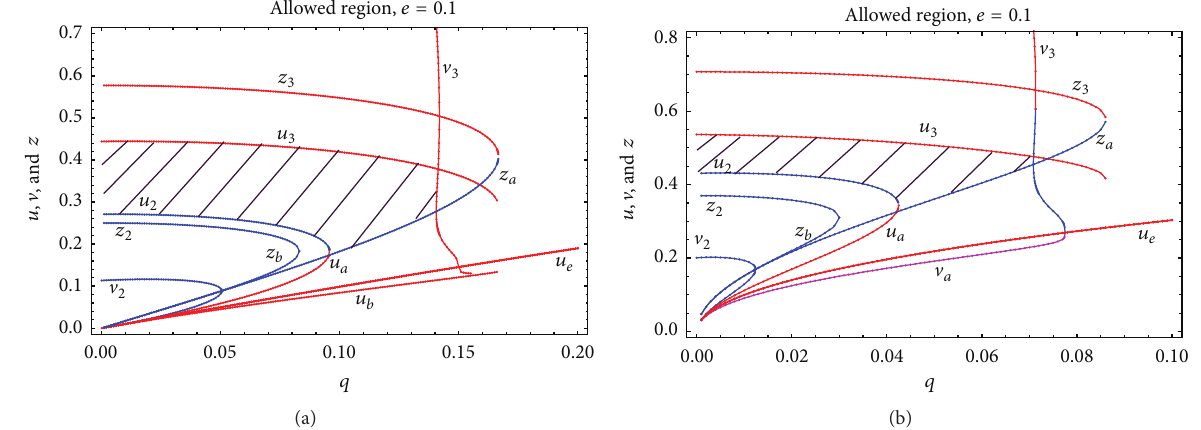
Figure 12: Allowed region (shaded) of the mixed phase for (a) AdS 4 and (b) AdS 5 for the energy and charge constraints 𝐸 < 0.9𝑀 𝑐 , 𝑄 < 0.9𝑄 𝑐 ; the charge of the radiation particle is set to be 𝑒 = 0.1 . For all plots, we set 𝑔 𝑏 = 0 , 𝑔 𝑓 = 30/7, 62/15 for AdS 4,5 in order to compare with the zero-charge case with 𝑔 𝑏 = 𝑔 𝑓 = 2